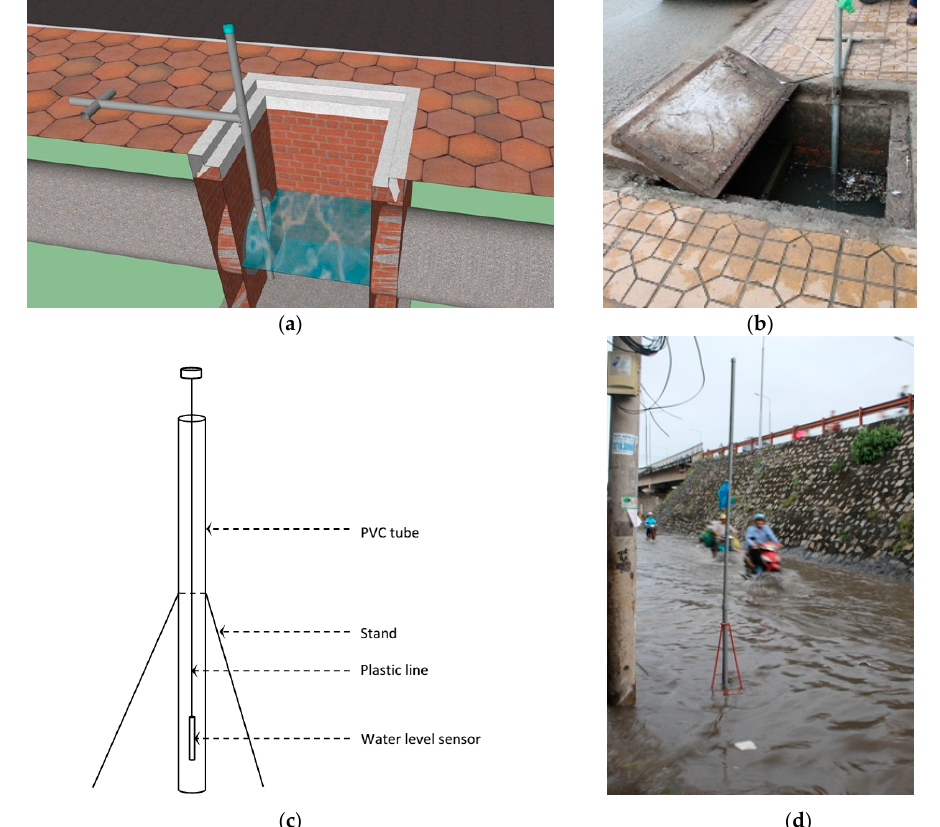
Figure 2. Water level measurement setups to measure the flood depths in sewers ( a , b ) and in streets ( c , d ) in Can Tho. ( c , d ) in Can